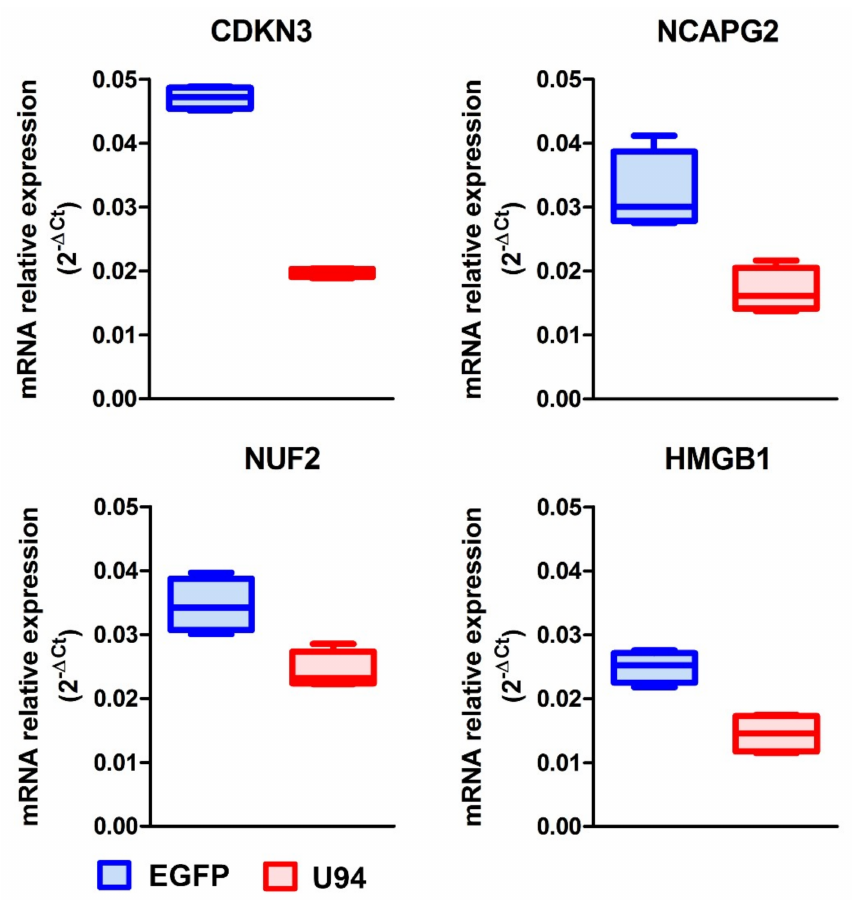
Figure 3. Validation of gene expression profile results by real-time PCR analysis. mRNA level of CDKN3, NCAPG2, NUF2 and HMGB1 was determined by real-time-PCR. Results are presented as 2 − ∆ Ct